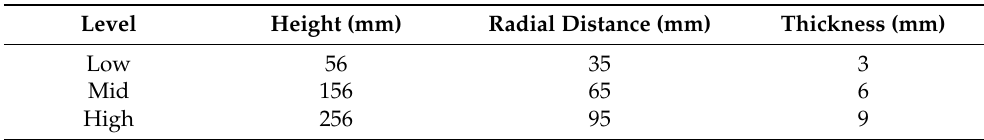
Table 1. DOE factor levels of the three build design parameters. Red numbers indicate factor levels that only exist in the machined